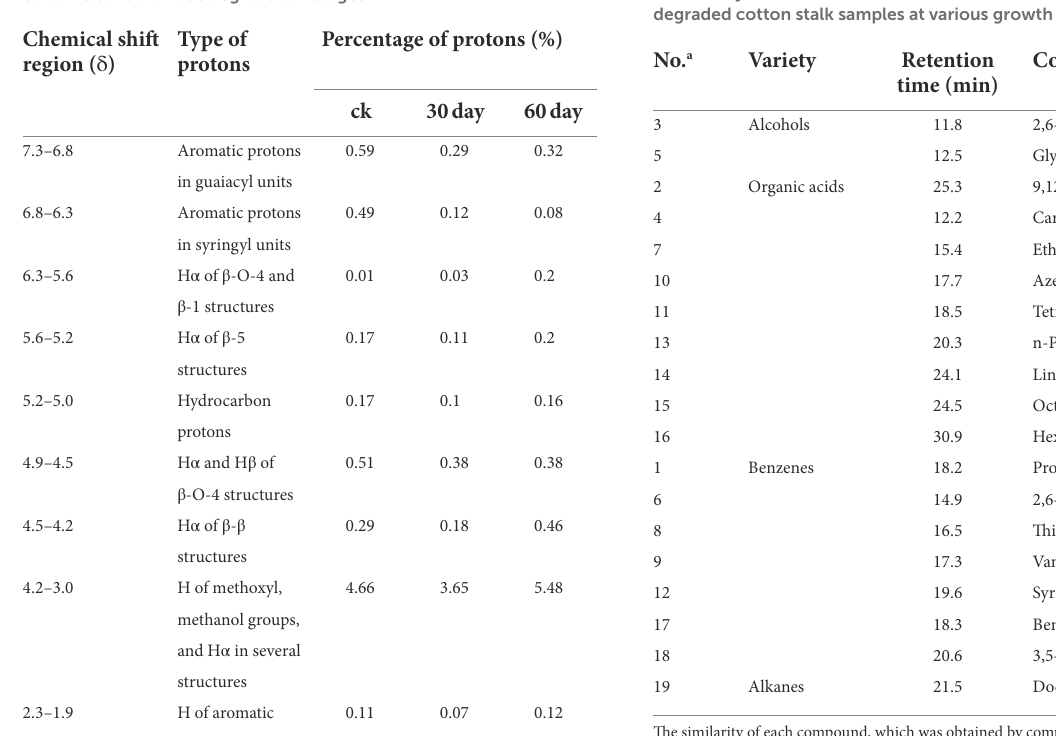
TABLE 3 1 H-NMR analysis of acetylated milled wood lignin from the cotton stalk at various degradation stages.